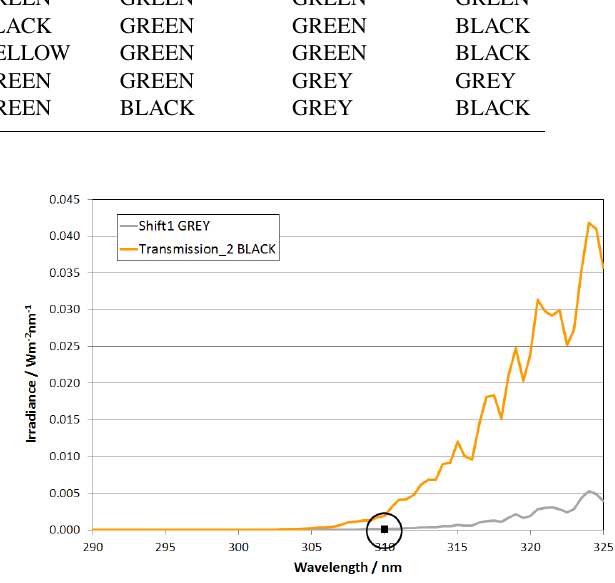
Figure 5. Exemplar spectra of two different cases. (1) Case of a GREY flag given to the potential shifts in the wavelength scale (in- dicator named Shift1). Spectrum measured by Brewer #037 in So- dankylä on 21 June 2003, at 20:26:33UTC. (2) Case of a BLACK flag given to the atmospheric transmission (indicator named Trans- mission_2). Spectrum measured by Brewer #037 in Sodankylä on 9 October 1992, at